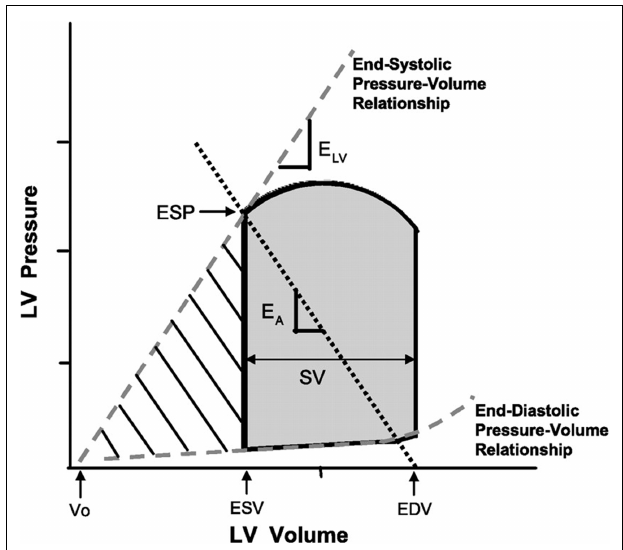
FIGURE 1 |Ventricular pressure–volume diagram from which effective arterial elastance (E A ) and left ventricular (LV) end-systolic elastance (E LV ) are derived. E A represents the negative slope of the line joining the end-diastolic volume (EDV) and the end-systolic pressure (ESP) points. E LV represents the slope of the ESP–volume relationship passing through the volume intercept ( V 0).The shaded area represents the cardiac stroke work, and the hatched area represents the potential energy. LV ESP is the LV pressure at the end of systole. EDV is the LV volume at the end of diastole. End-systolic volume (ESV) is the LV volume at the end of systole. Stroke volume (SV) is the volume of blood ejected by the LV with each beat and is obtained from subtracting ESV from EDV. From Chantler et al. (2008a) with